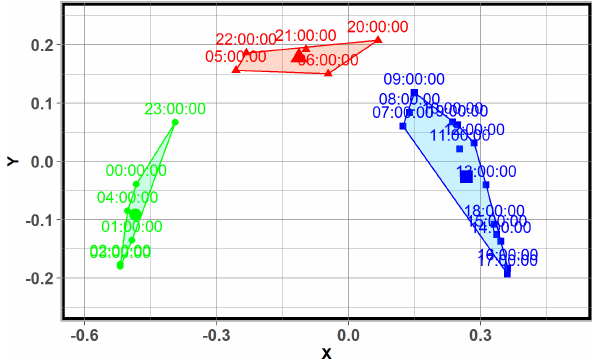
Figure 6: Cluster